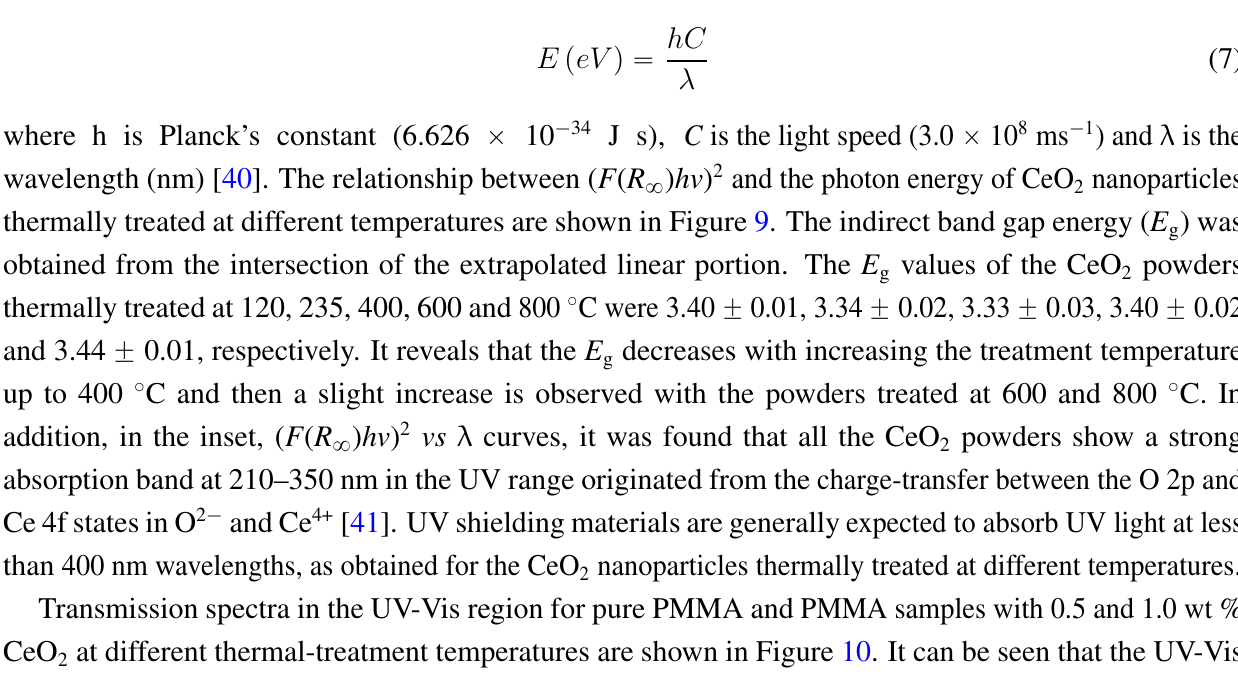
Figure 8. Cross-section SEM micrographs of PMMA with 1.0 wt % of CeO 2 nanoparticles sintered at ( a ) 400 °C; ( b ) 600 °C and ( c ) 800 °C.